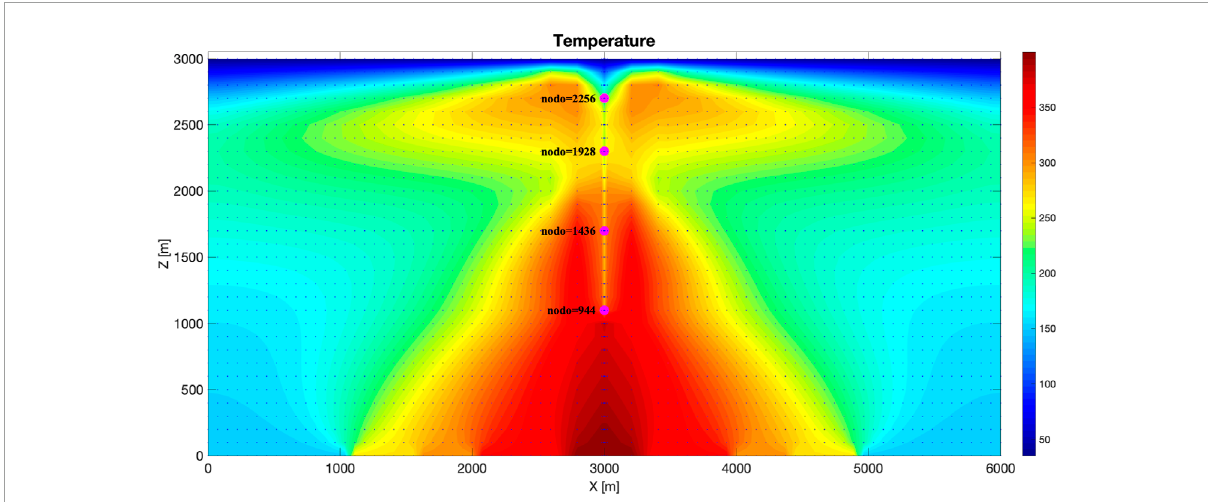
FIGURE 11 Temperature field in the Phlegraean Fields with the DBHE in service (200 years).